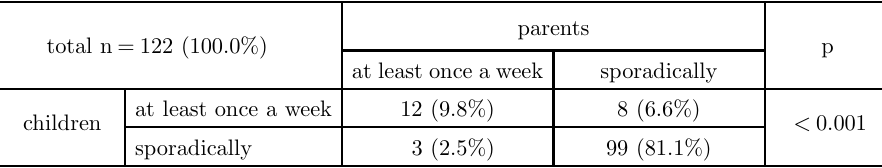
Table 2. Consumption of fast-food products by children and their parents total n = 122 (100.0%) children